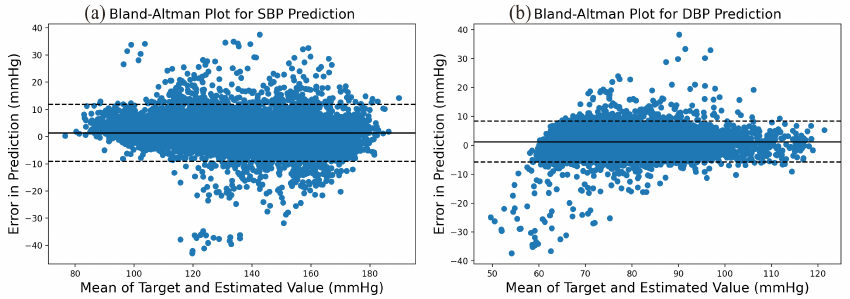
Figure 8. The prediction error of ( a ) SBP and ( b ) DBP.